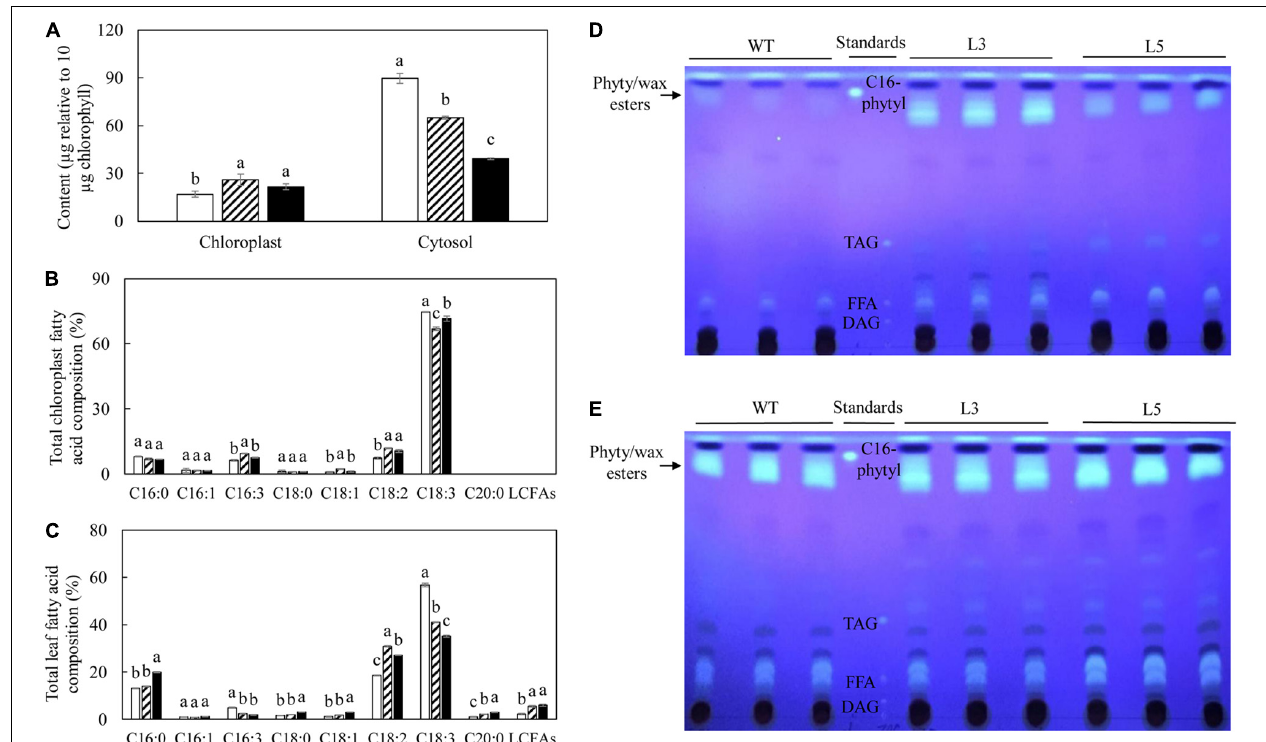
FIGURE 8 | Acyl distribution analysis in the potato senescent leaves of WT (open bar), L3 (bar with upward diagonal) and L5 (black bar). (A) TFA contents normalized for the same amount of chlorophyll; (B) Total chloroplast fatty acid composition; (C) Total leaf fatty acid composition; (D) TLC fractionation of fatty acid phytyl esters at the flowering stage; (E) TLC fractionation of fatty acid phytyl esters at the senescent stage. TFA content in cytosol was calculated via subtracting the TFA of chloroplast from the TFA content in leaf; the palmitoyl hexadecanoate was synthesized as C16- phytyl standard to indicate the probable location of phytyl esters band on TLC, the wax ester was slightly mingled with the phytyl ester bands. The data represent the mean values ± SD of three biological replicates. Letters (a, b, c, and d) above the bars are based on LSD, bars marked with different letters are statistically significantly different at P <